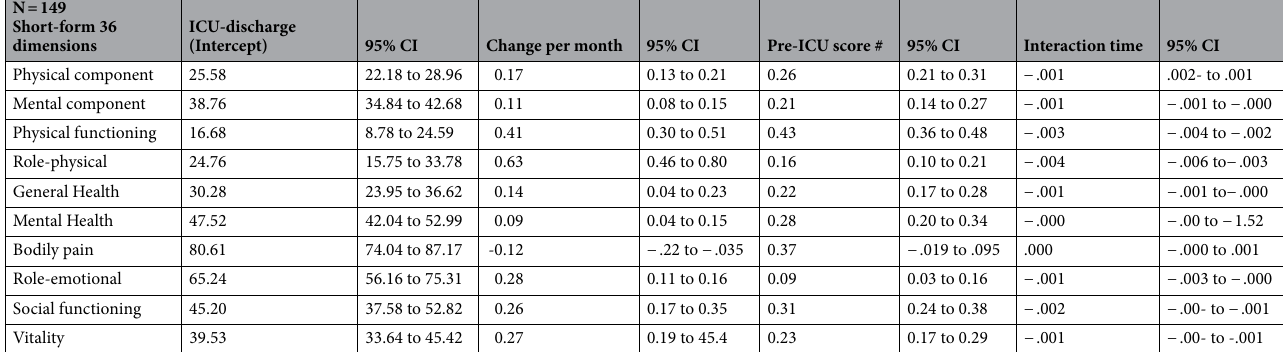
Table 3. Estimates of change over time from ICU discharge*. *linear mixed model with random intercept and random slope (for time). # Pre-ICU estimate: change in discharge-ICU score (intercept) for one point higher pre-ICU score. ICU intensive care unit, CI confidence